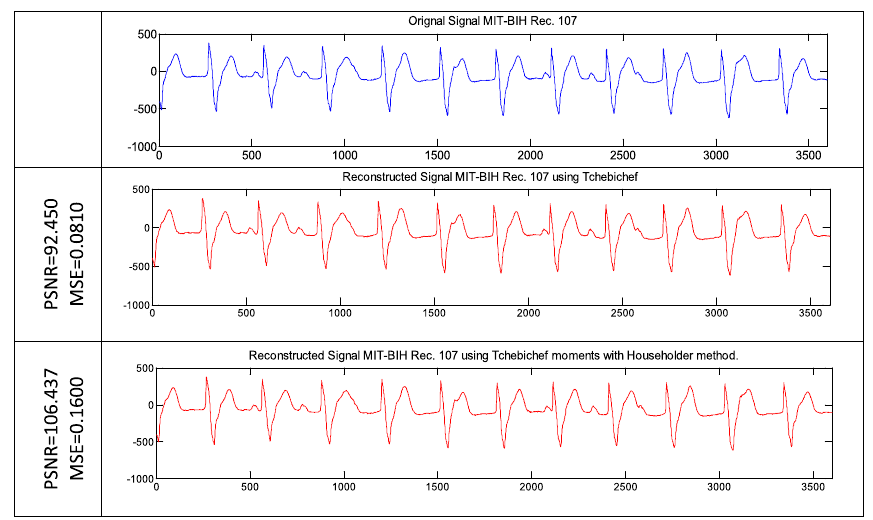
Fig. 2 Set of reconstructed “Rec. 107” signal using Tchebichef moments with and without the Householder